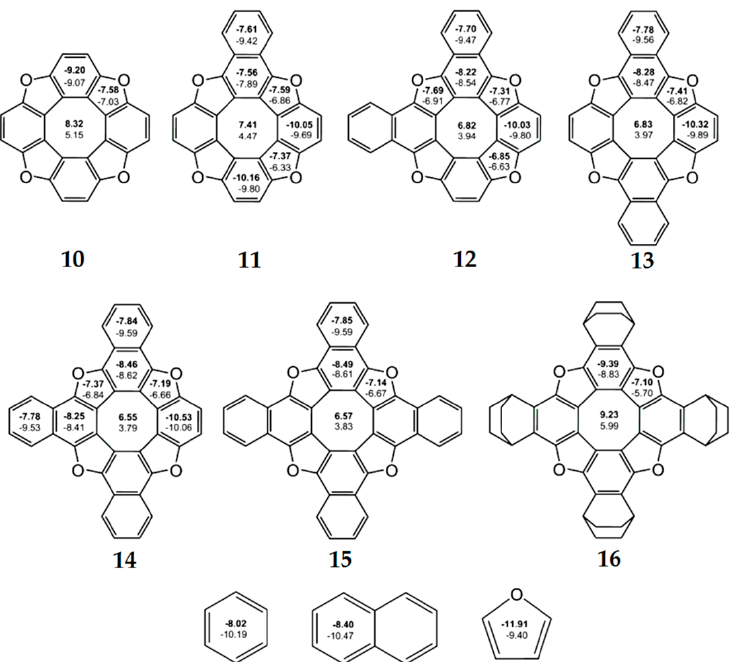
Figure 7. The values of NICS(0) (top number indicated in bold) and NICS(1) (bottom number) indices calculated at the GIAO/B3LYP/6-311+G(d,p) level of the theory for tetraoxa[8]circulene, benzene, naphthalene and furan molecules